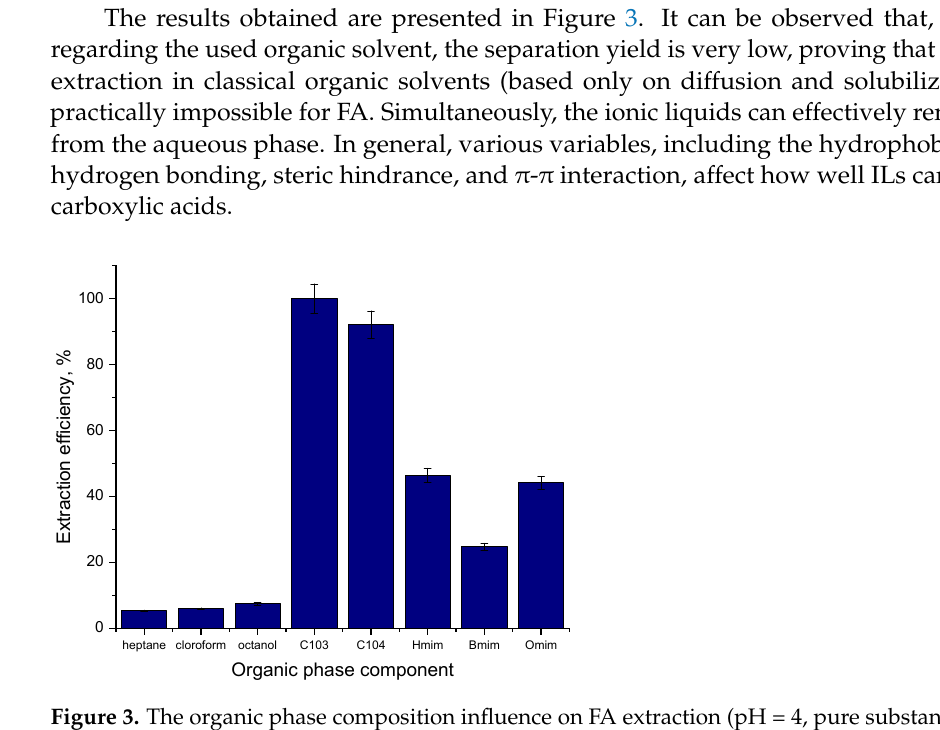
Figure 3. The organic phase composition influence on FA extraction (pH = 4, pure substances). The highest e ffi ciency was obtained for quaternary phosphonium salts: CYPHOS